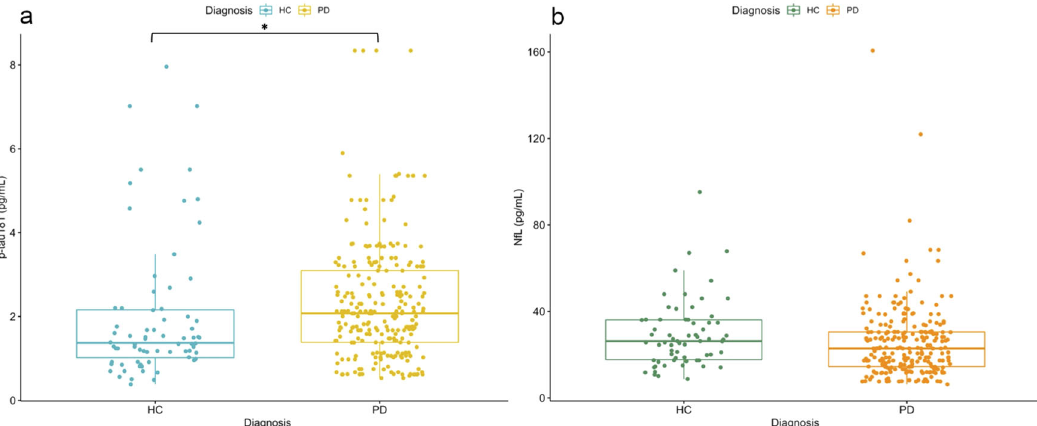
Fig. 1 Plasma p-tau181 and NfL concentrations in the different diagnostic groups. Scattered boxplots showing plasma p-tau181 concentrations in HC and patients with PD ( a ) and NfL concentrations in the same groups ( b ). *Signi fi cant difference ( P = 0.026), after adjusting for age and sex. PD Parkinson ’ s disease, HC healthy controls, pg/mL picograms per